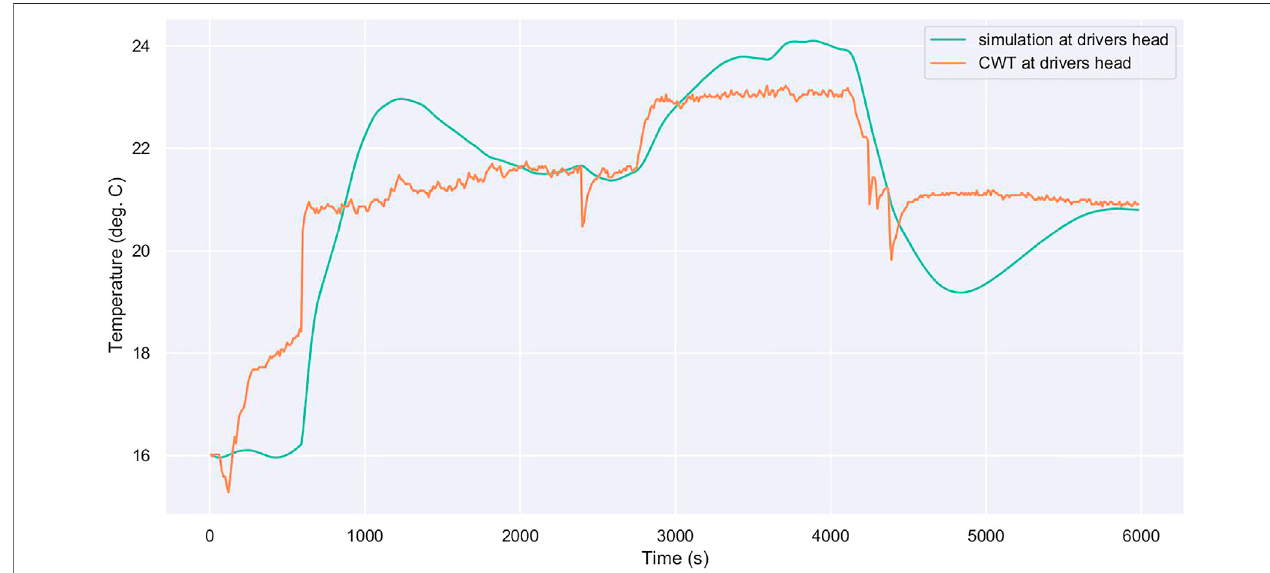
FIGURE 8 | Comparison of measurement and simulated data for CWT3 air temperature at the driver ’ s head. The trial settings are 22 ° C with vents set to defrost/ fl oor with recirculated distribution and 140 g h − 1 of moisture at 100 km h − 1 for 30 min, then switching to fresh distribution for 30 min, before switching all settings off for 30 min.